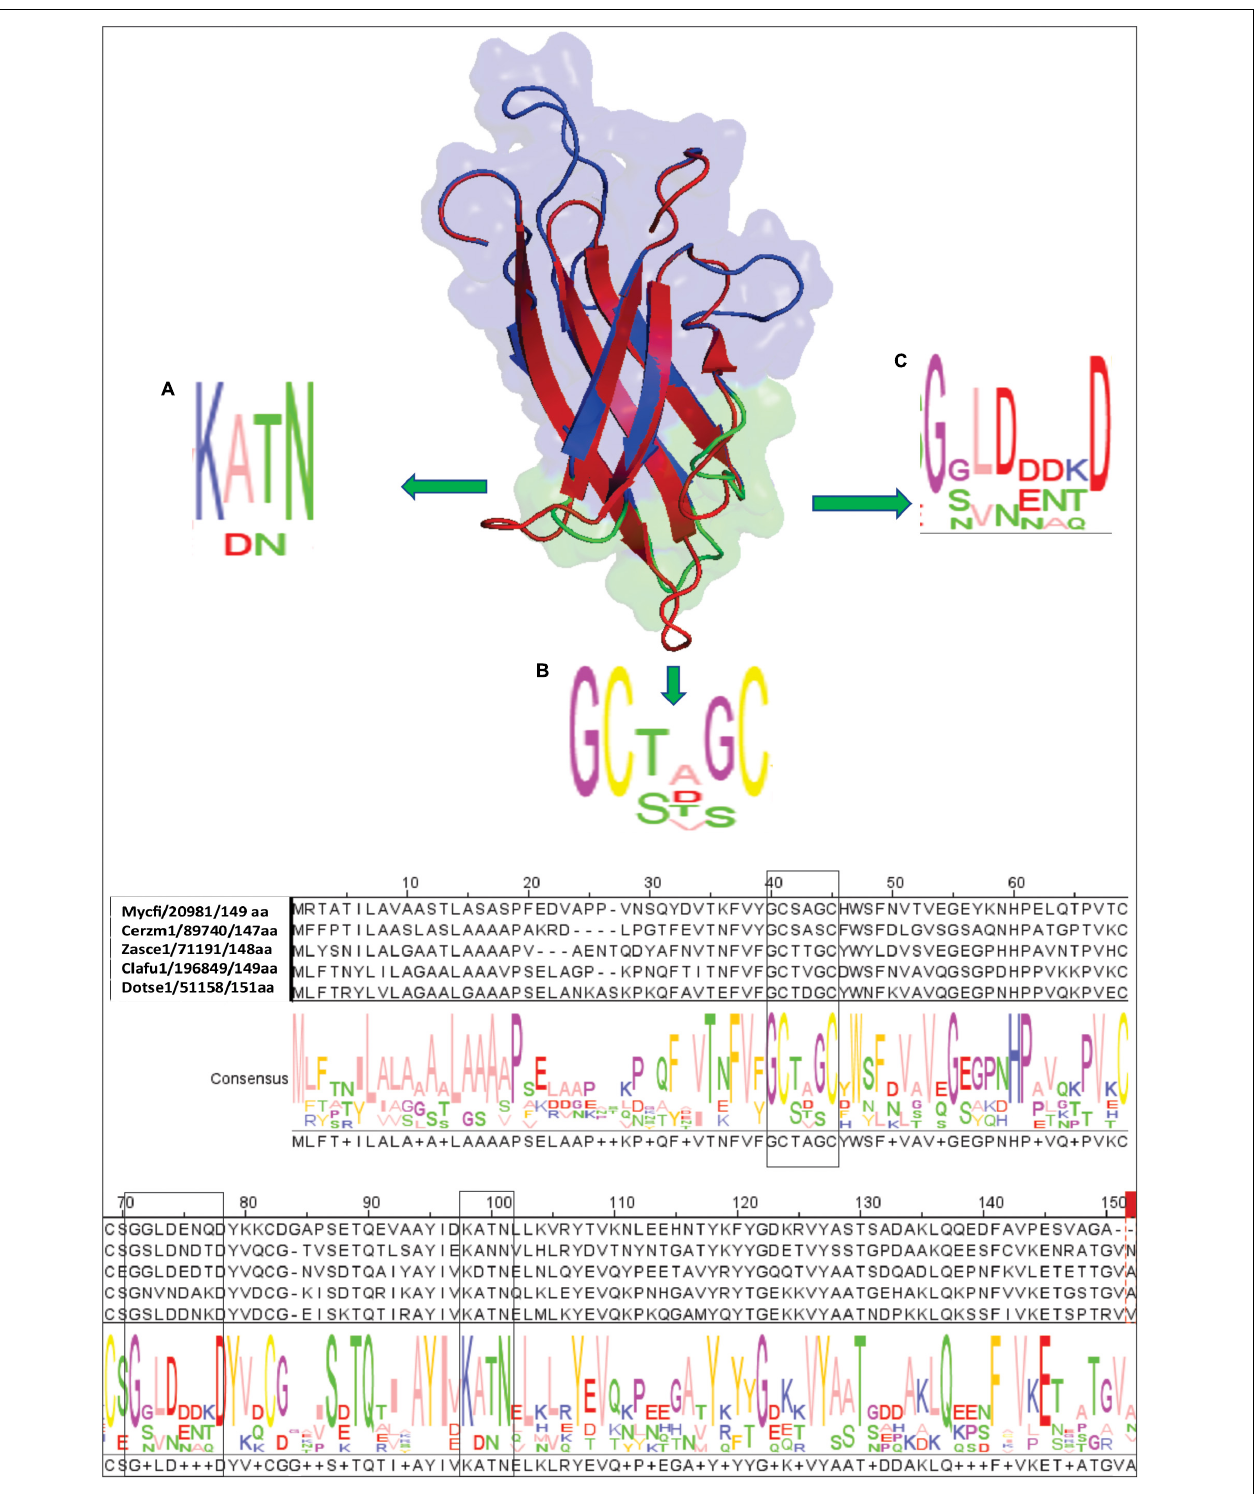
FIGURE 4 | Homology structural model of Ecp20-2. To generate the three-dimensional model, the amino acid sequence without signal peptide of Ecp20-2 was submitted to SWISS-MODEL online server. The best model was built based on the template of effector PevD1 with SMTL ID 5xmz.1 and illustrated by PyMol. The upper side shows a Cartoon view of a superimposed model of Ecp20-2 (in blue) with the PevD1 (in red) structure. Panels (A–C) show three loops of Ecp20-2 (in green) expected to be involved in interaction with other molecules. Consensus regions and residues conserved among homologs in other fungi were shown in panels (A–C) . The lower part is the alignment of the Ecp20-2 sequence with boxed consensus